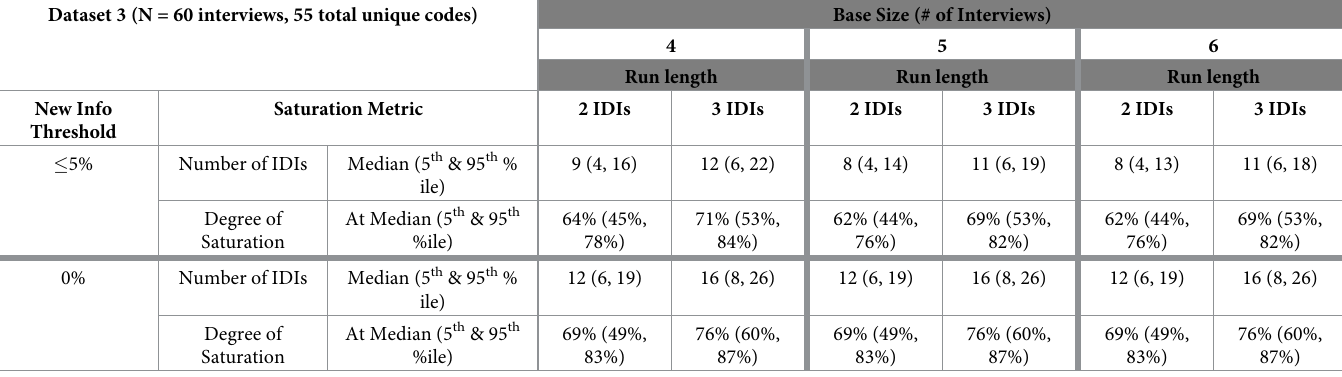
Table 4. Dataset 3 bootstrap distribution: Median number of interviews to reach saturation and degree of saturation at different base sizes and run lengths. Dataset 3 (N = 60 interviews, 55 total unique